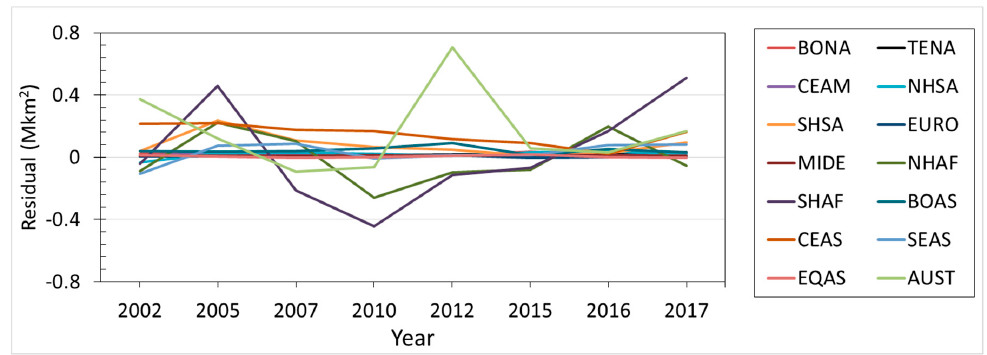
Figure 14. BA estimations of the MCD64A1 and FireCCILT10 products for the continental regions.